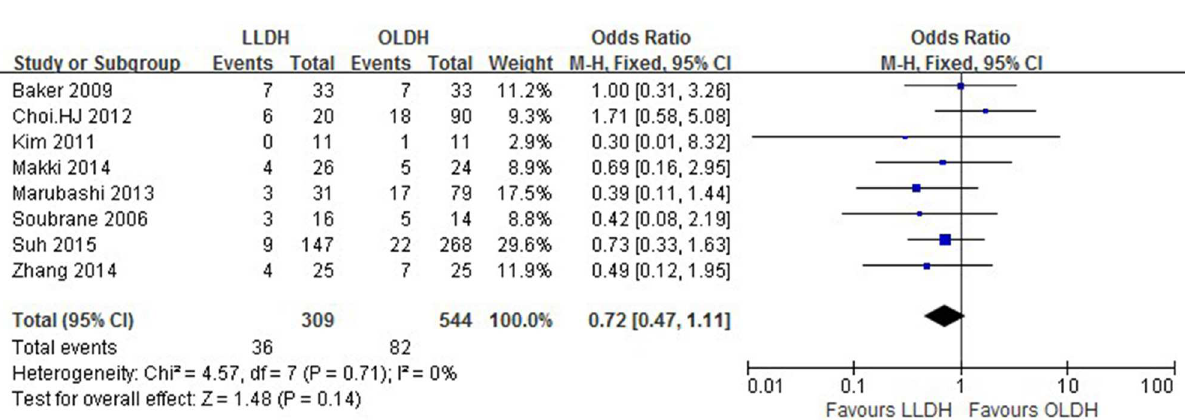
Fig 4. Forest plot displaying the results of the meta-analysis on overall complication.